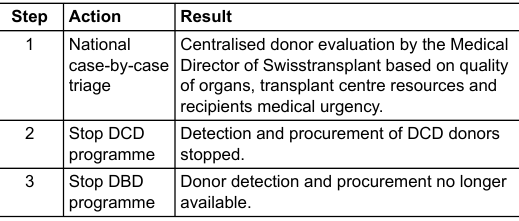
Table 1: The steps of the “Swiss COVID-19 pandemic stepwise shut- down approach” that were applied to organ donation and procurement